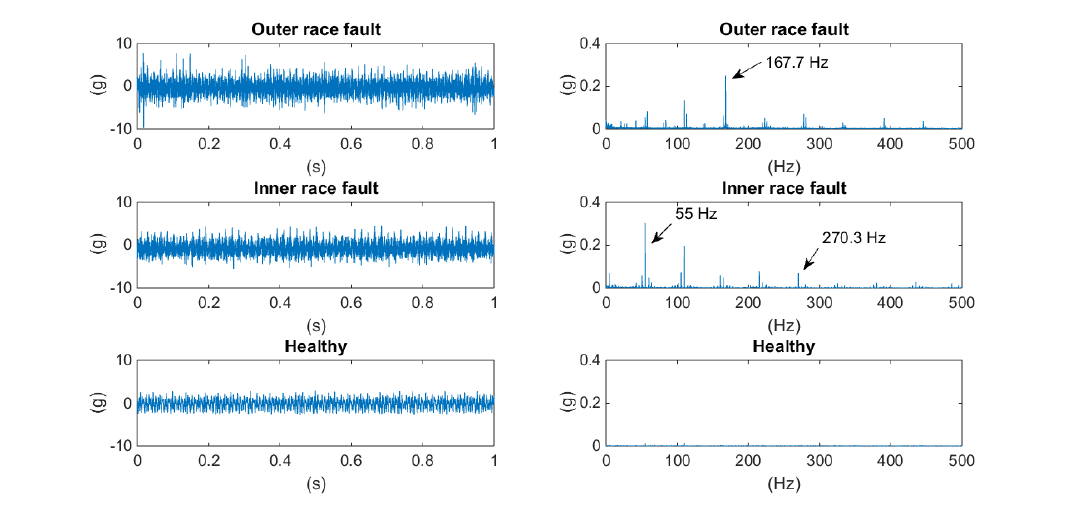
Figure 2. Raw data ( left ) and corresponding spectrum ( right ) for faulted and healthy bearings. The text arrows point to fault frequencies and rotation